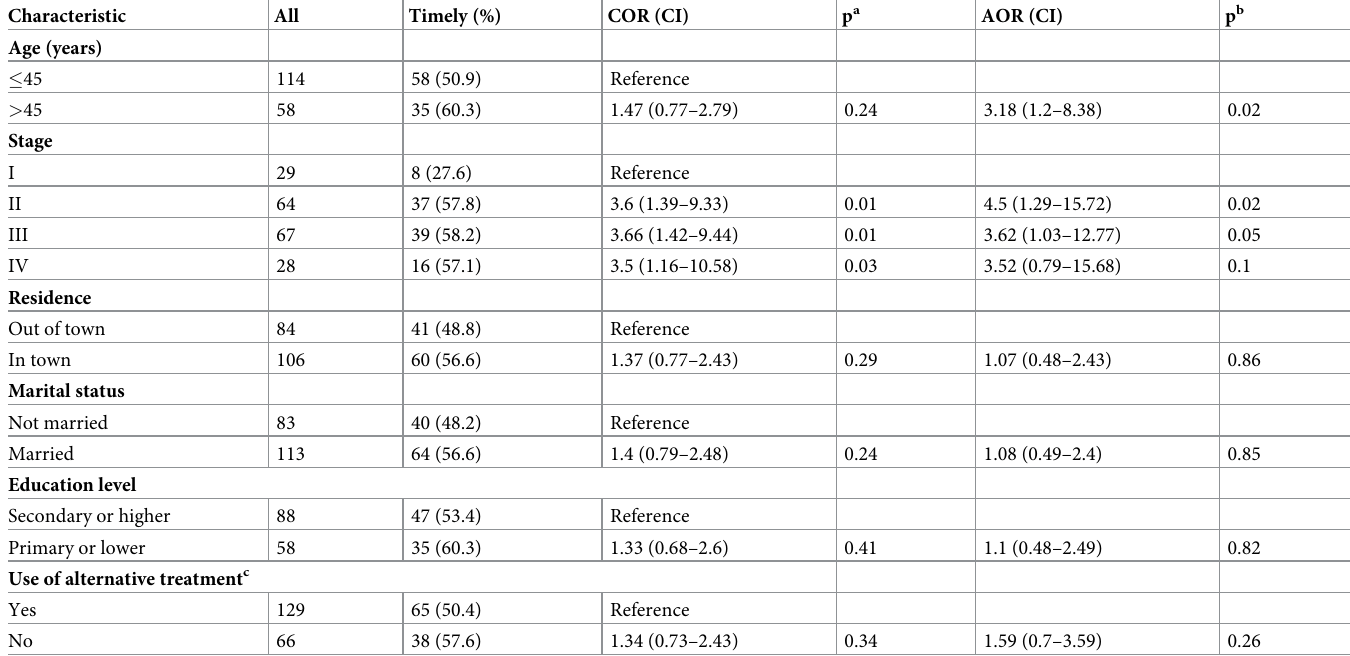
Table 3. Simple and multivariate logistic regression for factors associated with timely systemic treatment initiation ( � 90 days since pathological diagnosis) of breast cancer patients.